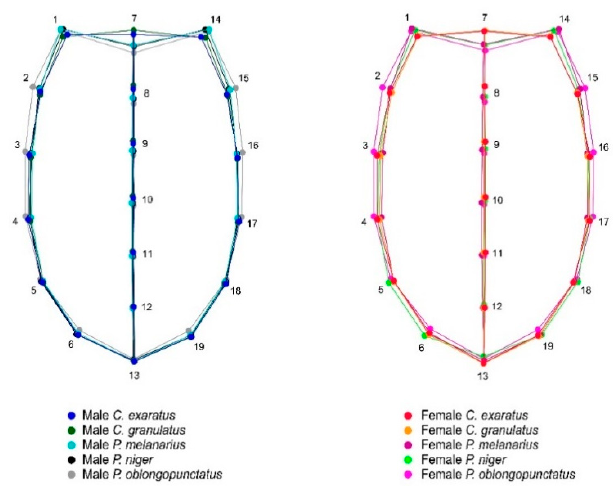
Figure 3. Wireframe representation of the superimposition of average elytral shapes and their corresponding landmarks between males and females in all the corresponding analyzed species in this study: Carabus exaratus , Carabus granulatus , Pterostichus melanarius , Pterostichus niger , and Pterostichus oblongopunctatus . * The wireframe was aligned using starting shape.